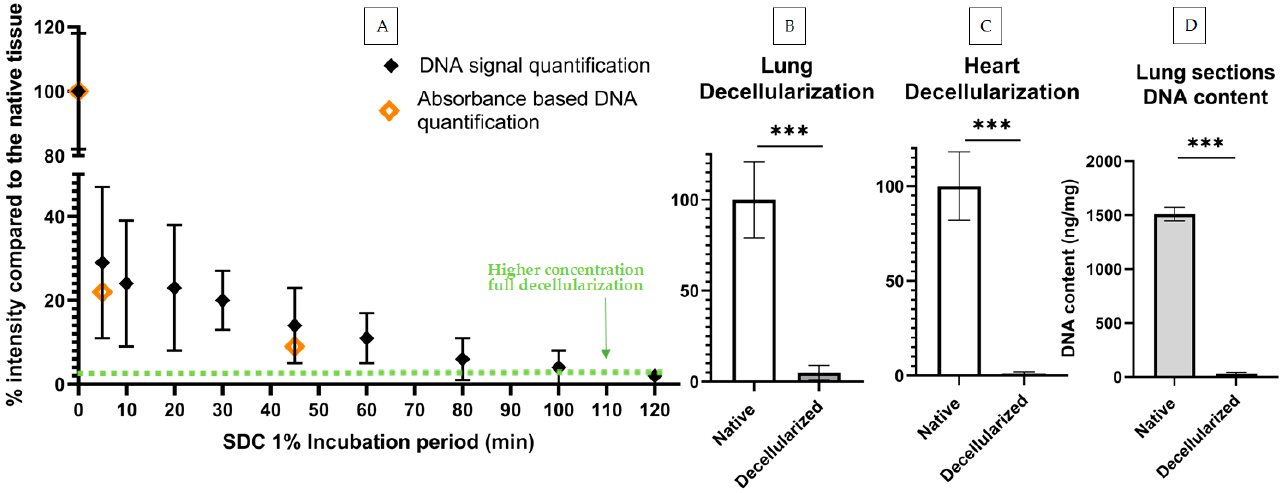
Figure 4. Lung and heart decellularization assessment via DNA signal quantification and DNA content quantification. ( A ) DNA signal quantification ( n = 5, min of 8 sections per datapoint) and DNA content quantification ( n = 1, a min. of 12 sections per datapoint) of decellularization protocols with increasing decellularization periods: results shown in % in comparison to the average DNA signal of the native tissue (100% intensity). Green dotted line corresponds to signal % of lung sections decellularized with standard concentration protocol (SDC 2%) ( B ) DNA signal comparison of native and decellularized lung sections (min. of 4 sections per datapoint) ( C ) and heart sections (min. 4 sections per datapoint). ( D ) DNA content of native and decellularized lung sections obtained by UV-absorbance DNA quantification (min. 12 sections per datapoint). Statistical significance between native and decellularized groups was verified using unpaired t-tests, *** indicates p < 0.001. DNA signal quantification of decellularization protocols with increasing decellularization periods: Results shown in % in comparison to the average DNA signal of the native tissue (100% intensity). All timepoints showed significant statistical differences ( p < 0.05) versus native tissue (here shown as t = 0 min). A minimum of 10 image sets were taken for each lung section.